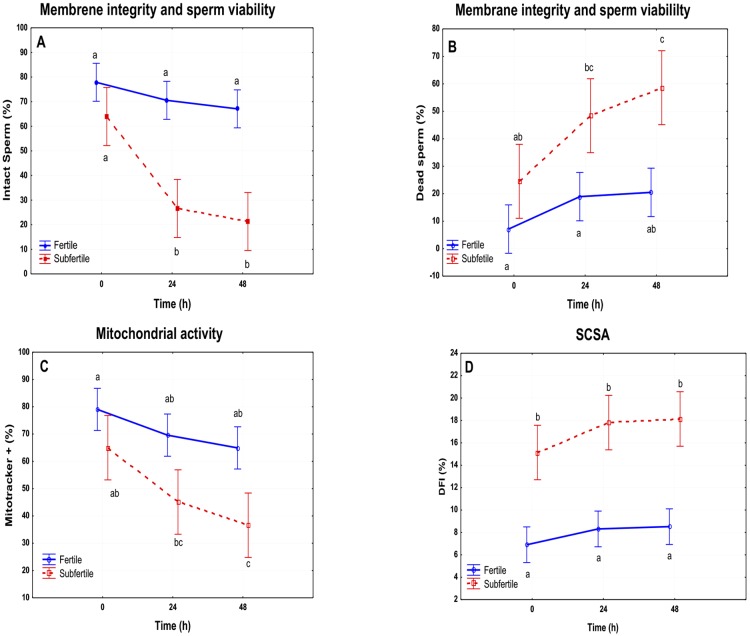
Graphical representation of the results obtained by flow cytometry in fertile vs subfertile stallions.A. Membrane integrity and sperm viability of sperm: Percentage of intact sperm at T0, T24 and T48 h of refrigeration. B Membrane integrity and sperm viability of sperm: Percentage of dead sperm at T0, T24 and T48 h of refrigeration. C. Mitochondrial activity: percentage of active mitochondria on sperm at T0, T24 and T48 h. D. DNA fragmentation Index of sperm at T0, T24 and T28h. a, b; p ≤ 0.05.